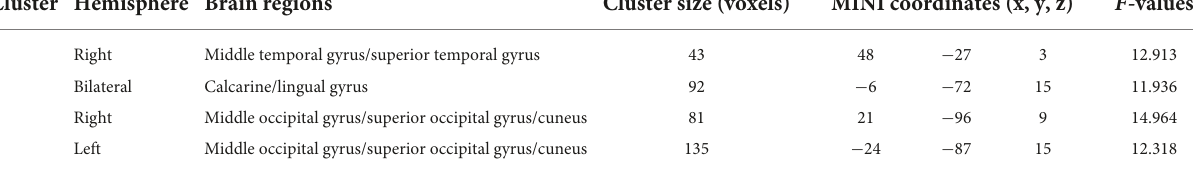
TABLE 2 Brain regions showing significant group differences in dALFF values.